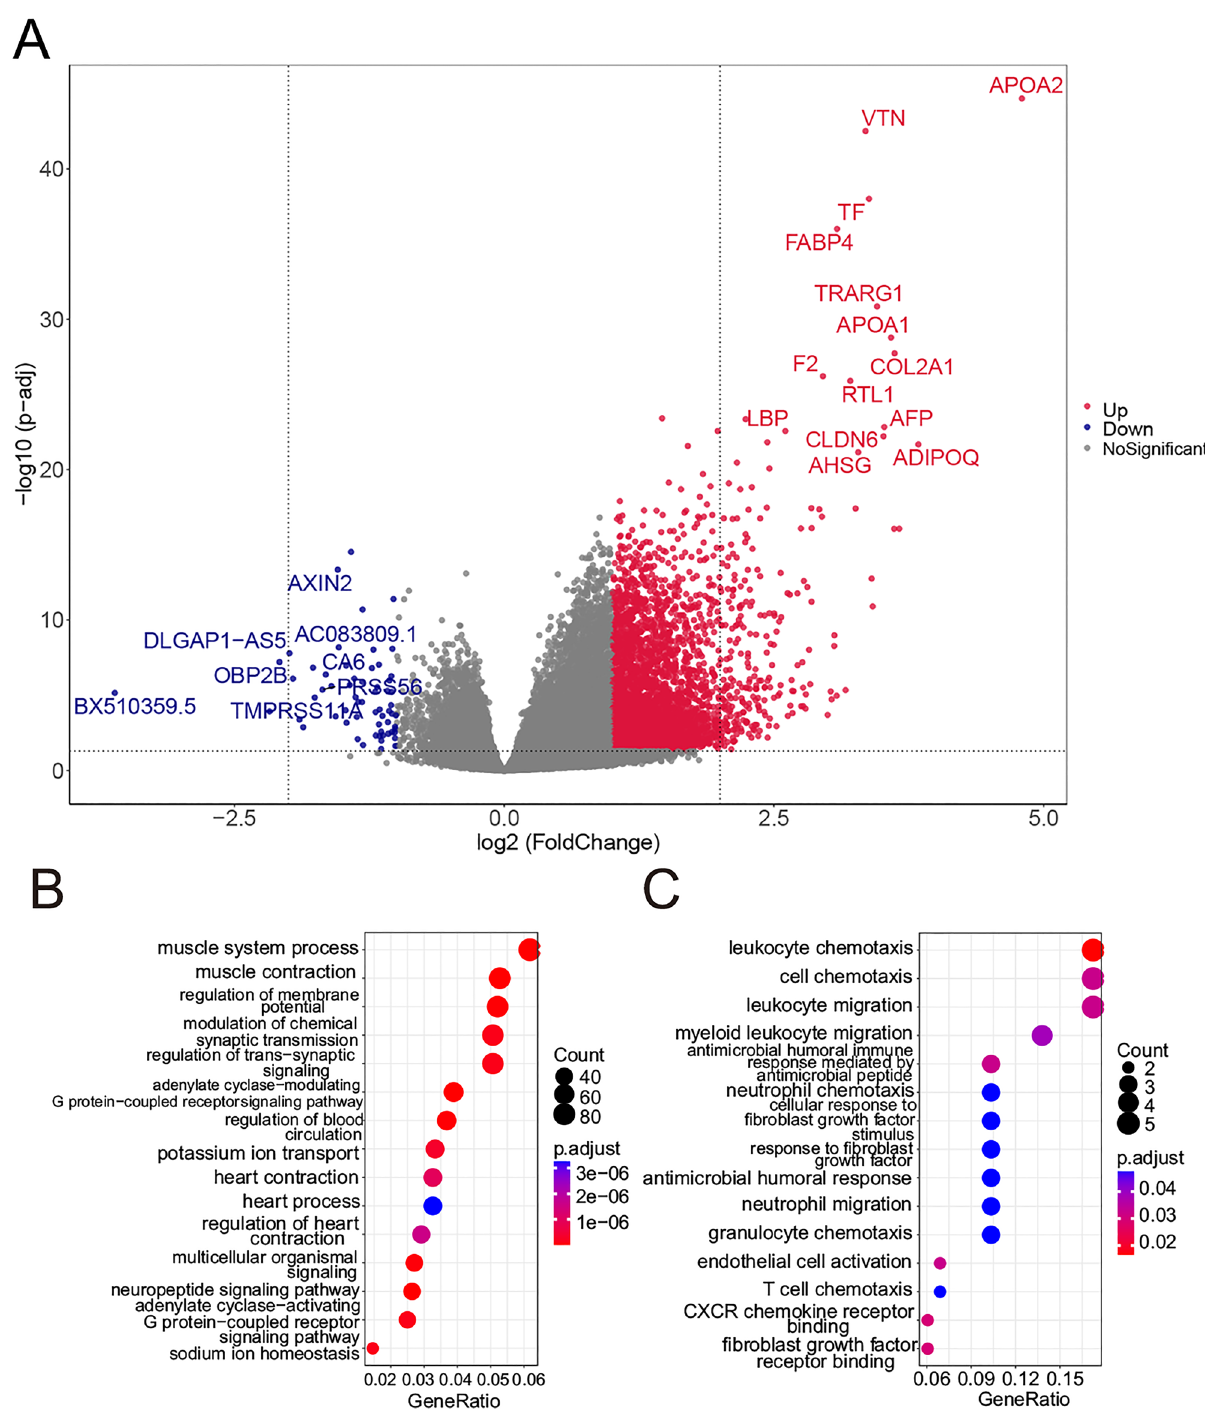
Figure 5. The distinct patterns of gene expression between high-risk group and low-risk group. ( A ) Volcano plot shows the differentially up-regulated genes (red nodes) and down-regulated genes (blue nodes). The bubble plots show the functional enrichment analyses of up-regulated genes ( B ) and down-regulated genes ( C